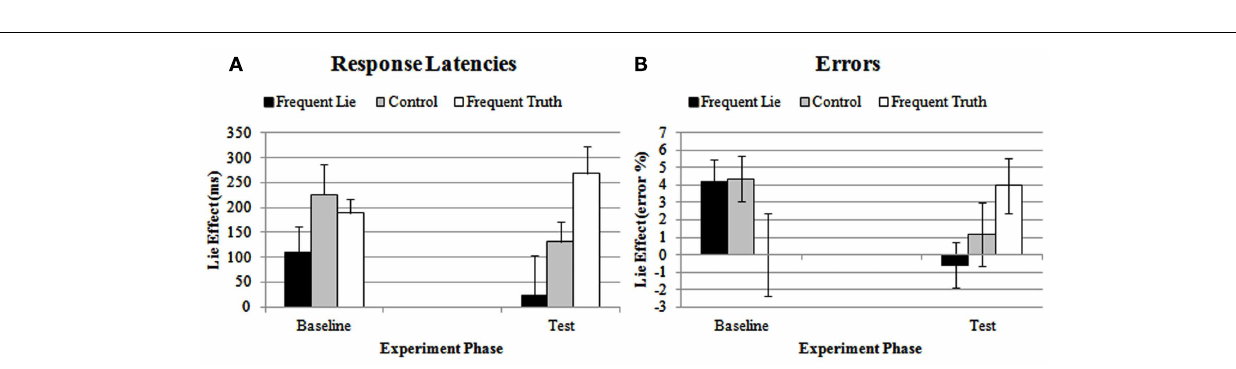
Frontiers in Psychology | Cognitive